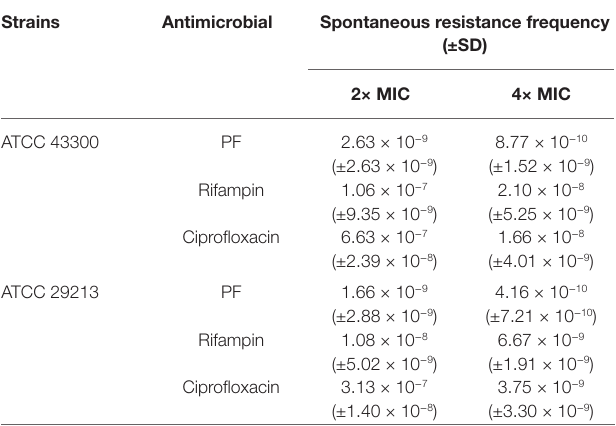
TABLE 2 | Spontaneous resistance frequencies of PF for S. aureus . Strains